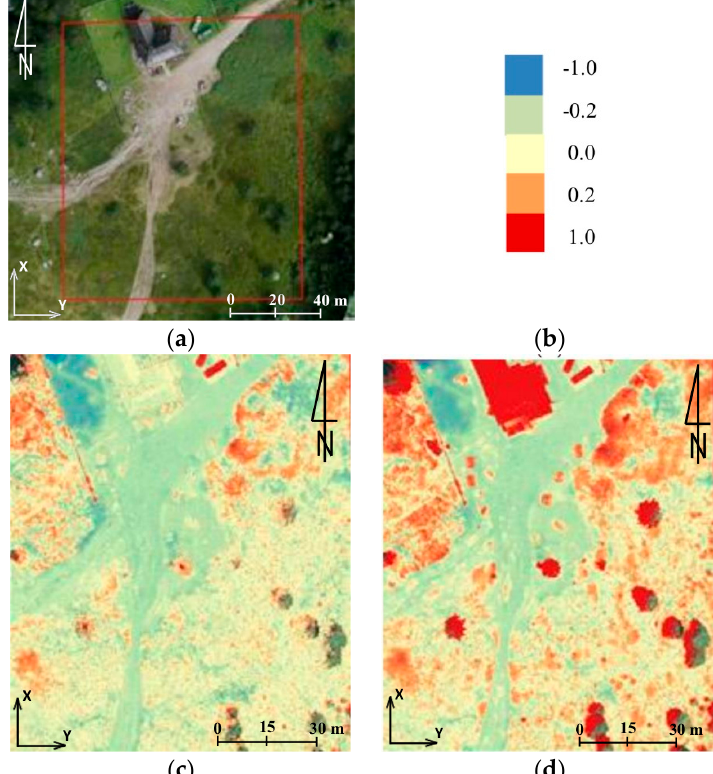
Figure 14. The mountain shelter in Hala Kondratowa: ( a ) the study area, ( b ) colour scale (the units